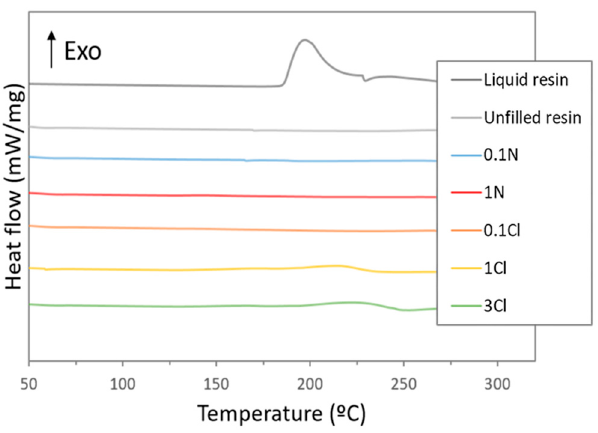
Figure 6. DSC thermograms of the liquid and post-cured resins containing the silver precursors. In order to evaluate whether the resin with the larger amount of AgClO 4 (3 wt%) ing processes were carried out for longer times, in particular for 180 and 300 min. For